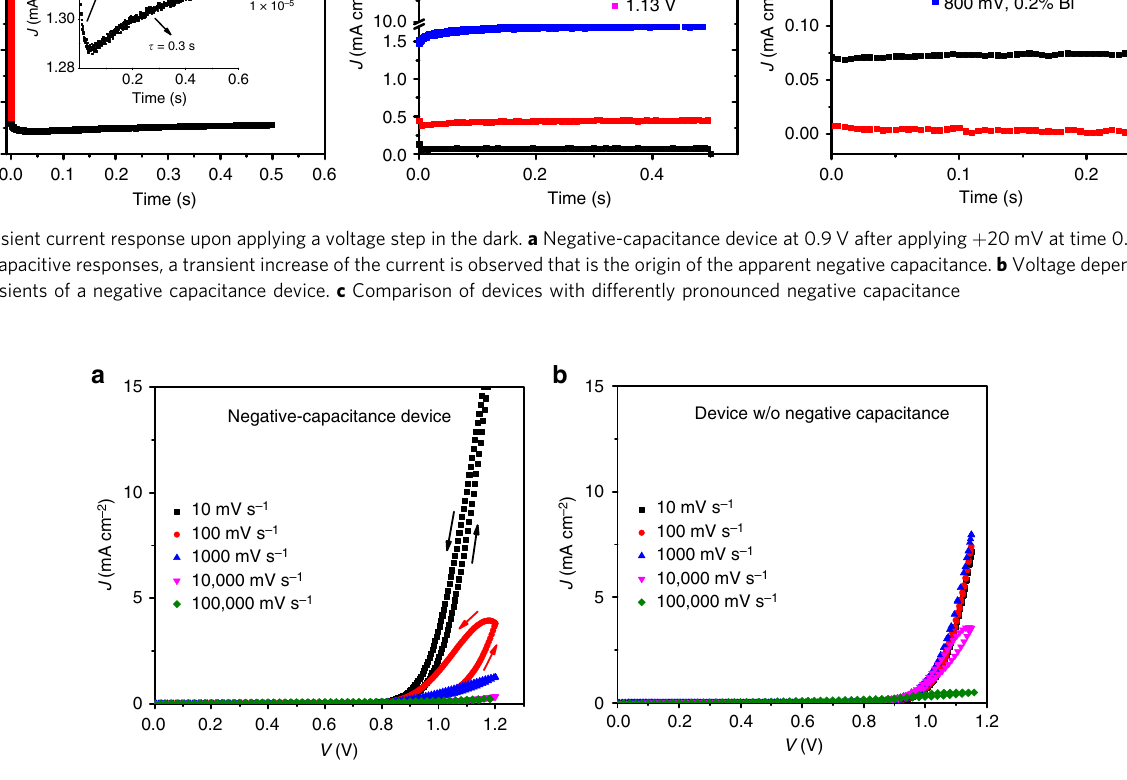
Fig. 5 JV curves in the dark starting at 0 V for different scan rates. a Negative-capacitance device, b Device without negative capacitance. In case of negative capacitance, the dependence of forward current on scan rate is much more pronounced at lower scan rates